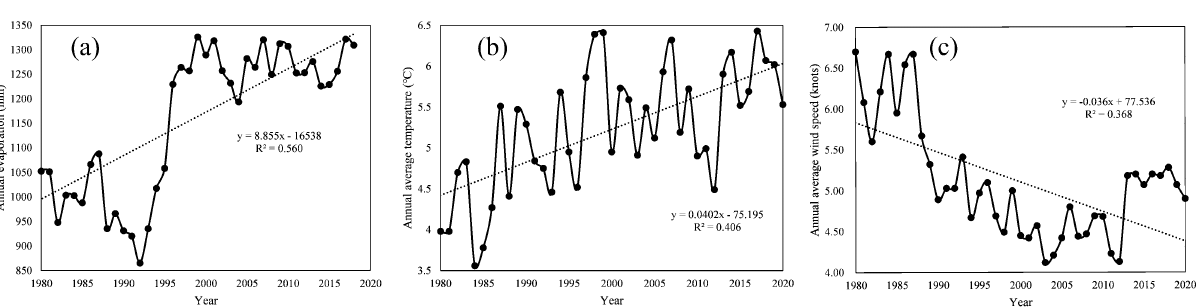
Figure 9. Spatial distribution of surface runoff in different seasons in Daihai Basin.